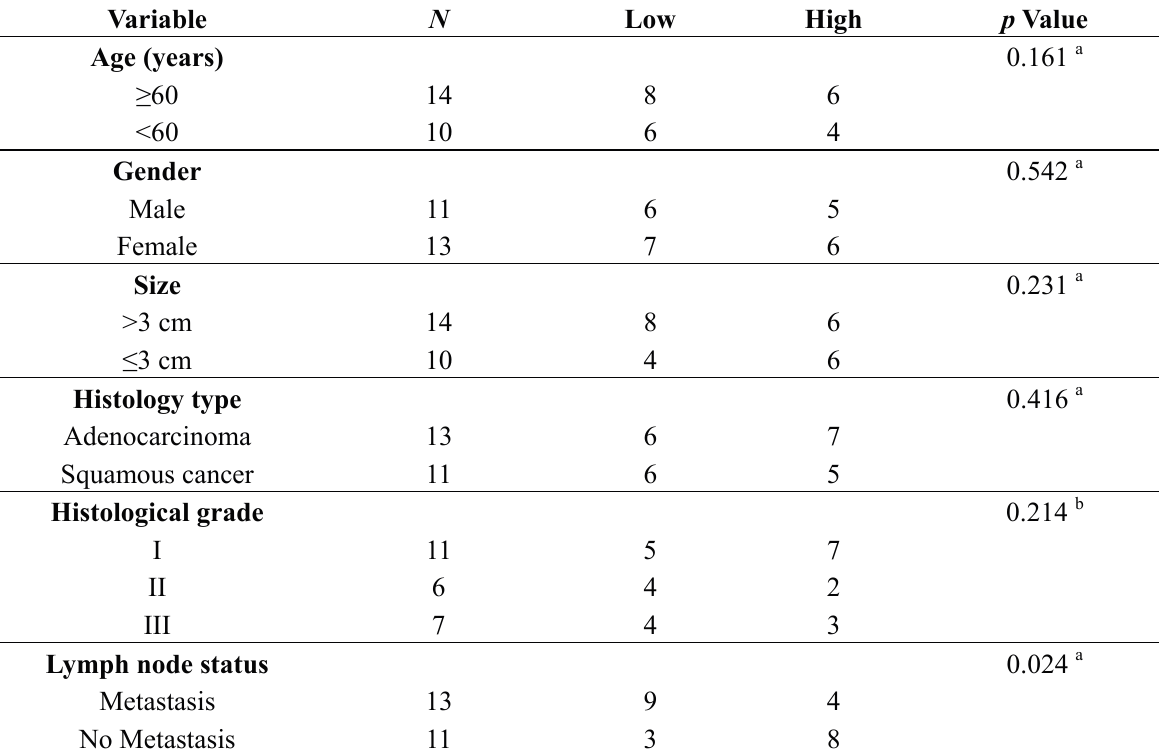
Table 1. Relationship between miR-143 and clinicopathological variables in NSCLC tissues.